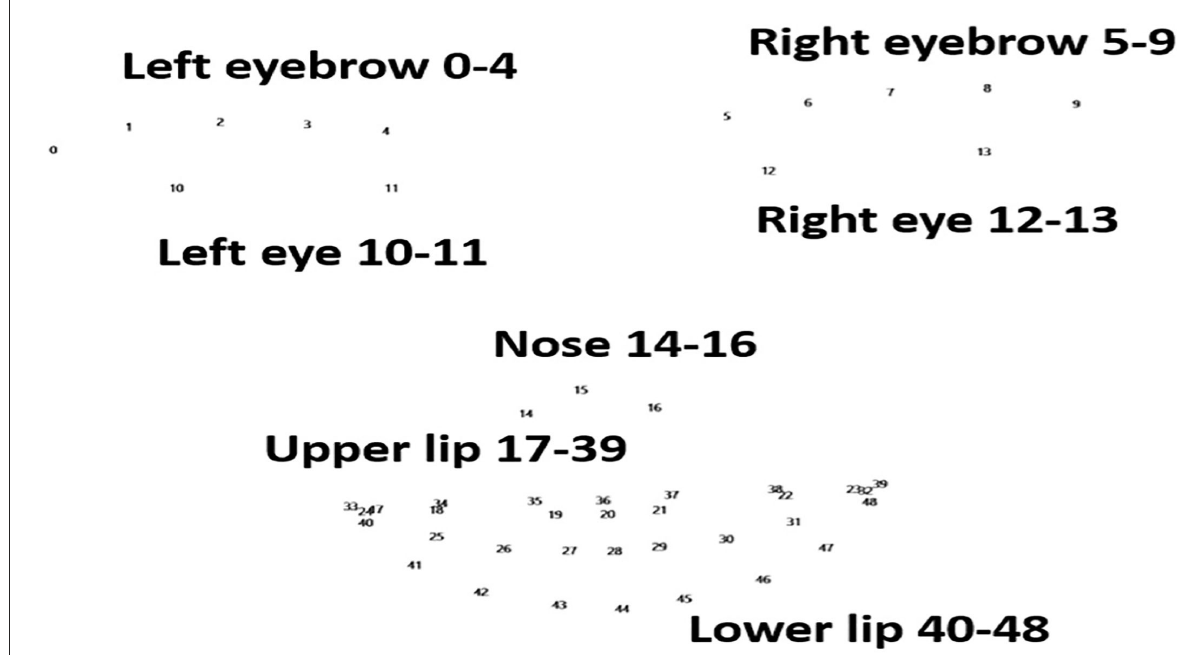
FIGURE1 Landmarks of the face. Numbers 0–48 represent the 49 landmarks in the face, involving the eyebrows, eyes, nose, upper lip, and lower lip. These are the points recognized by FaceReader (version 7.0; Noldus Information Technology, Wageningen,